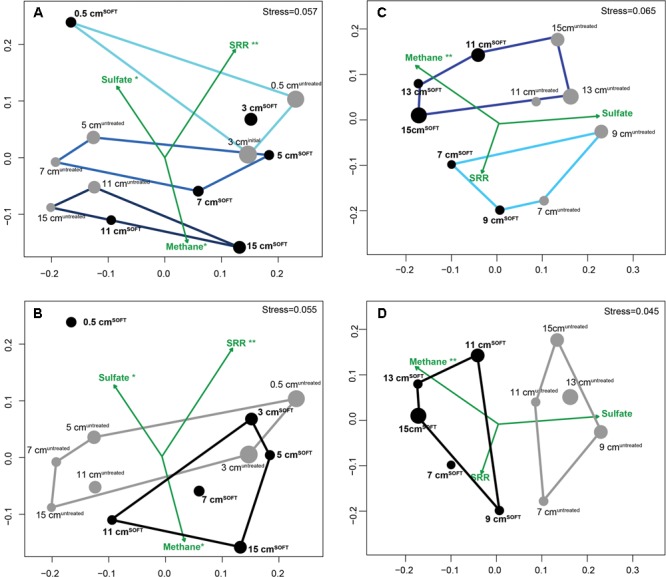
Similarity of bacterial (A,B) and archaeal (C,D) communities visualized by non-metric multidimensional scaling (NMDS) of Bray–Curtis dissimilarity matrices based on OTU0.945 relative abundance data with environmental variables fitted as vectors. Gray dots represent untreated sediment subsamples and black dots represent SOFT sediment subsamples. The size of the dots reflects the evenness of the subsamples (inverse Simpson index). Defined subgroups are depicted as polygons. Dataset for SOFT core layer 0.5 cm depth was excluded from the analysis because this layer became oxic and was influenced by an oil slick forming on top of the core during the experiment. Significance levels are indicated next to the tested parameters methane, sulfate, and sulfate reduction rates (∗∗p < 0.01; ∗p < 0.1). SRR, sulfate reduction rates.